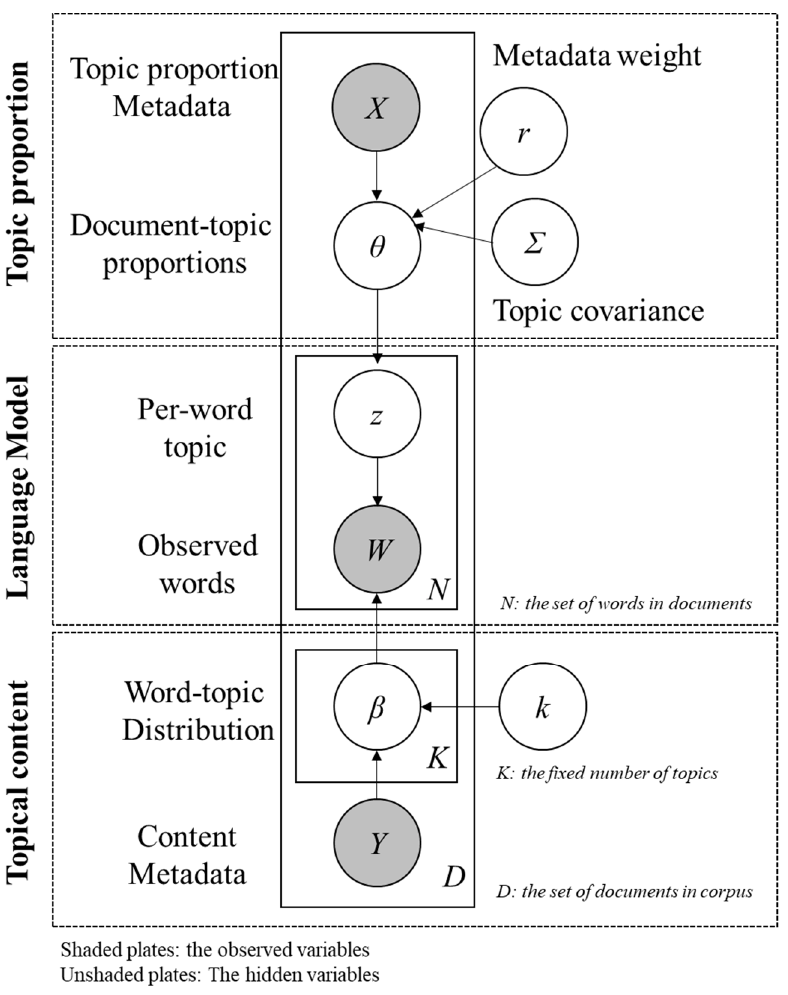
Figure 1. Graphical illustration of STM (adapted from Roberts et al. [23] ).